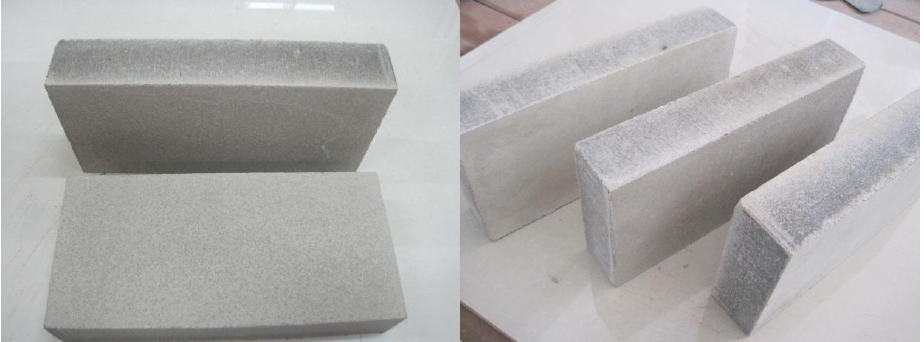
Figure 6. Photographs of autoclaved bricks according to the aggregate gradation model.